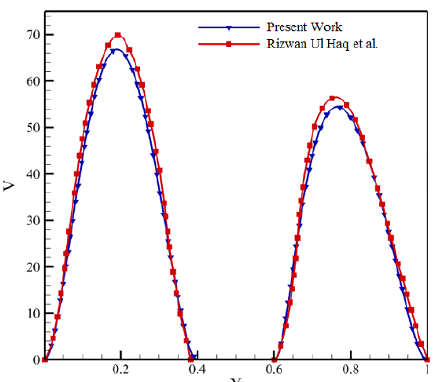
Figure 3. The V ‐ velocity profile along the Y ‐ direction at ( φ = 0, Ra = 10 5 and L = 0.4) obtained by the present work and the results of Haq et al. [54].